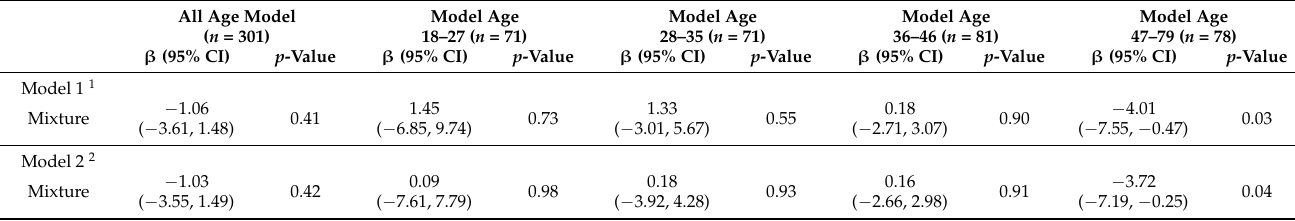
Table 4. Mohawk adults from the age-stratified quantile g-computation method of Model 1, including congener groups of high-chlorinated PCBs, low-chlorinated PCBs, HCB, DDE, and mirex, and Model 2, including total PCBs, HCB, DDE, and mirex. Models 1 and 2 were adjusted for sex and education levels. All age models were adjusted for age category, sex, and education levels.